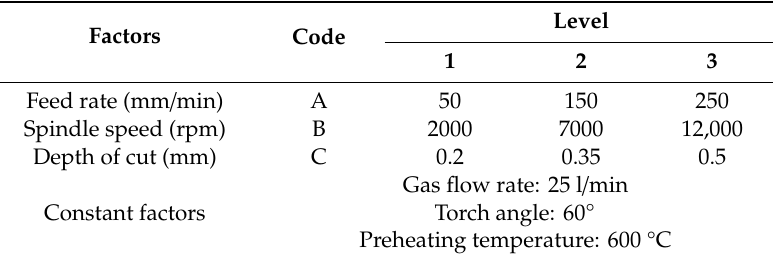
(cid:16) (cid:17) 3 4 Table of orthogonal